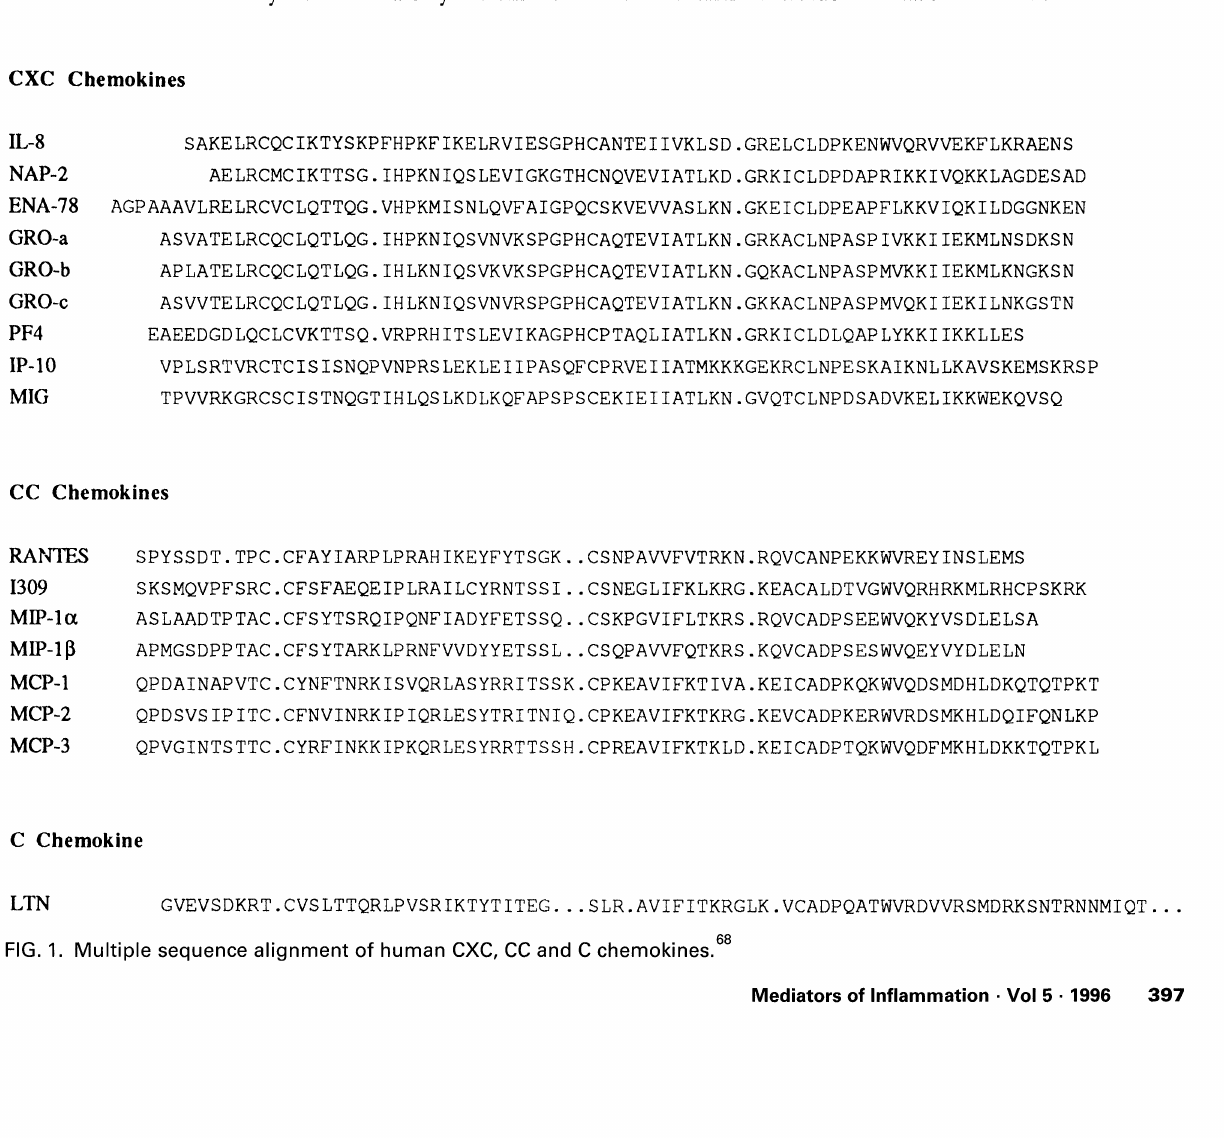
8 FIG. 1. Multiple sequence alignment of human CXC, CC and C